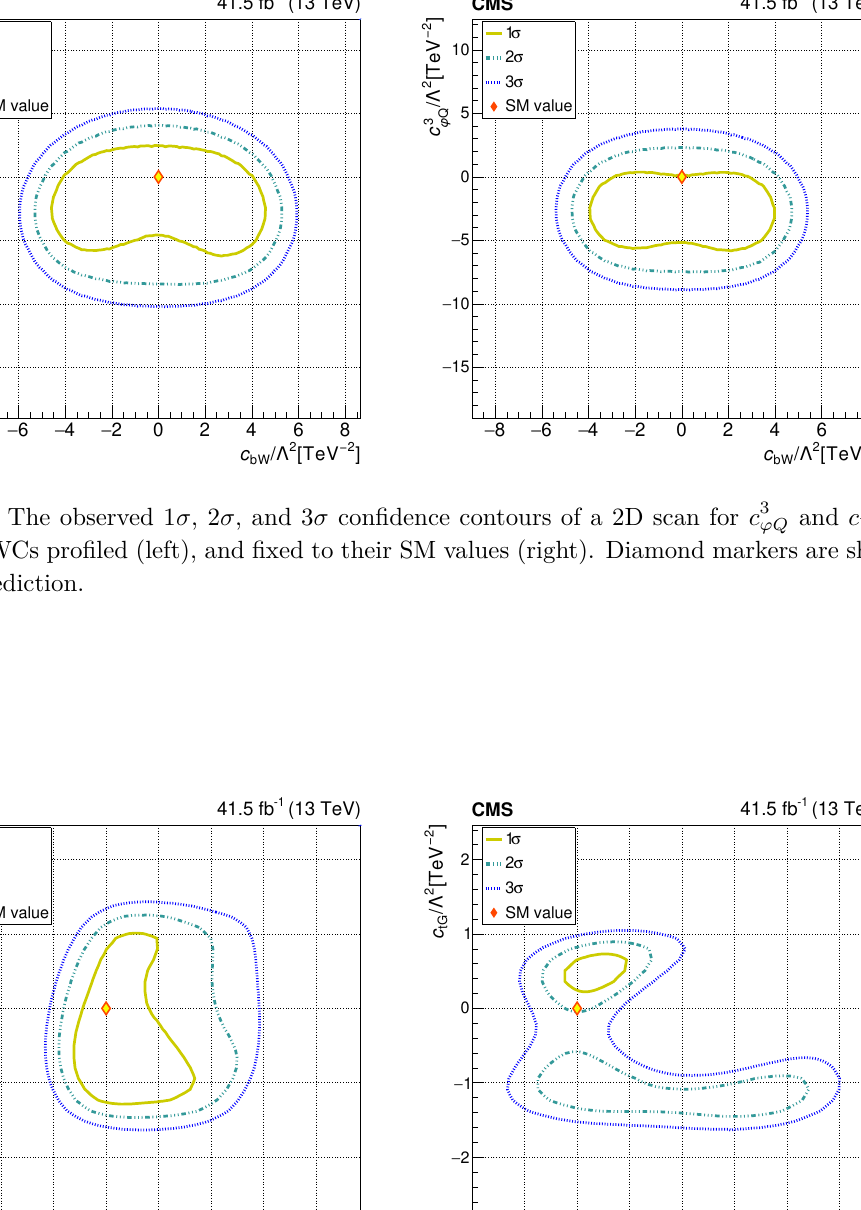
Figure 8 . The observed 1 σ , 2 σ , and 3 σ confidence contours of a 2D scan for c other WCs profiled (left), and fixed to their SM values (right). Diamond markers are shown for the SM prediction. The range on the right plot is modified to emphasize the 1 σ